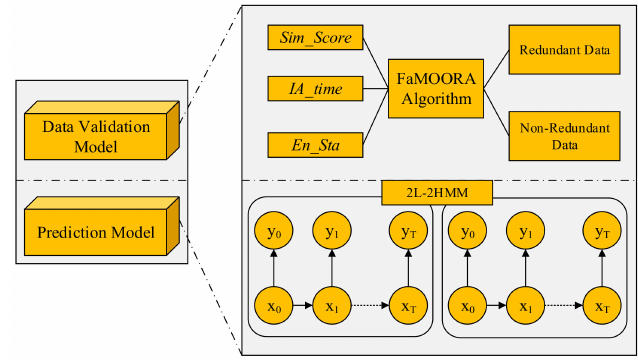
Figure 3. Structure of Data On-Looker